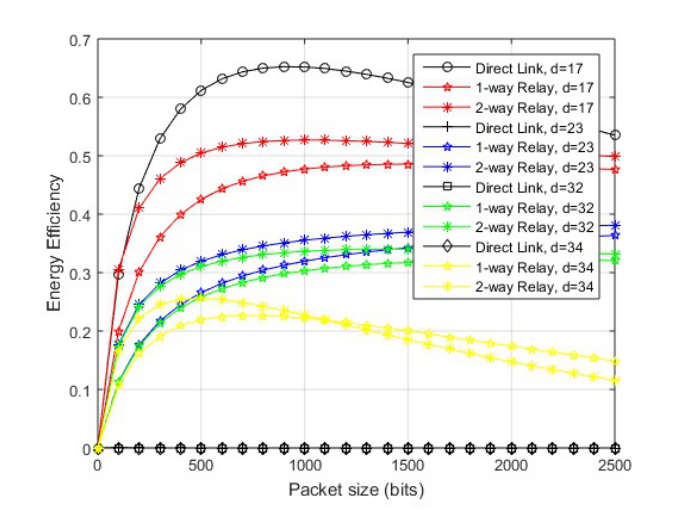
Figure 6. Energy efficiency vs. packet size (in-body communication).